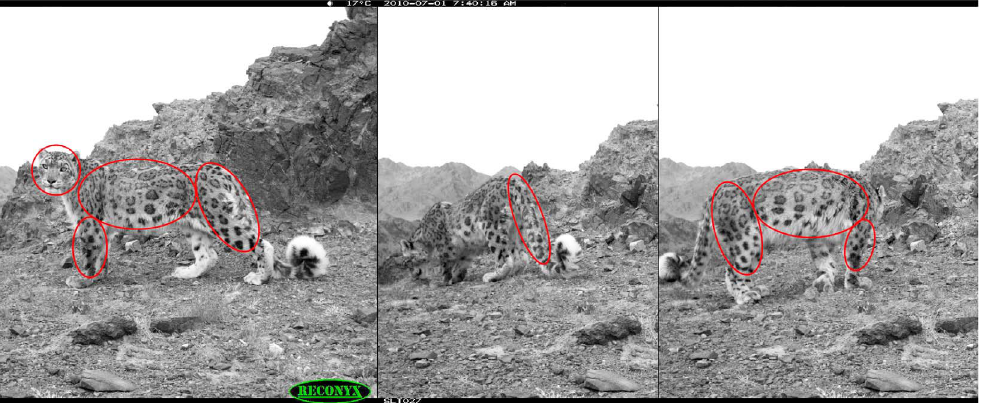
Figure 3. Multiple images with more than one body part of the snow leopard could be photographed using a single camera trap capable of taking multiple images rapidly ( , 1 second intervals). Here we show 3 out of the 30 different photos of a male snow leopard taken on the same encounter during the 2 minutes that he lingered in front of the camera. These images were used to create references for identifying 8 body parts, including face, tail, and both flanks, hindlegs and forelegs of this particular snow leopard.